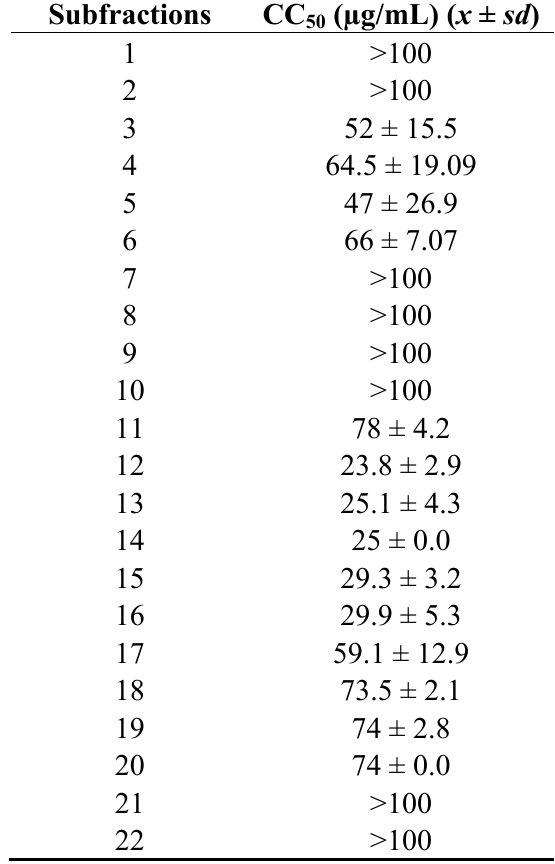
Table 1. CC (µg/mL) of the subfractions obtained from fraction EAF#3#2 in Caco-2 50